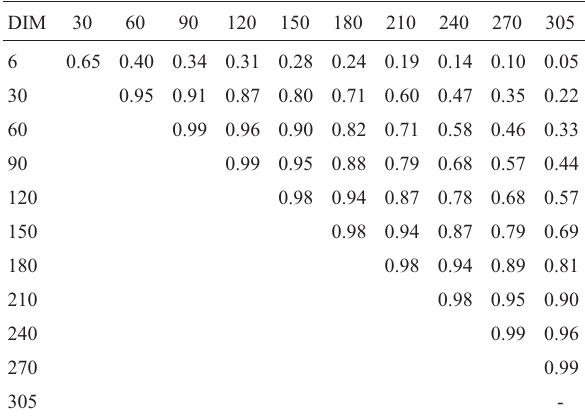
Table 9 - Permanent environmental correlation estimates between se- lected DIM of daily yields obtained by the RRM2 model.